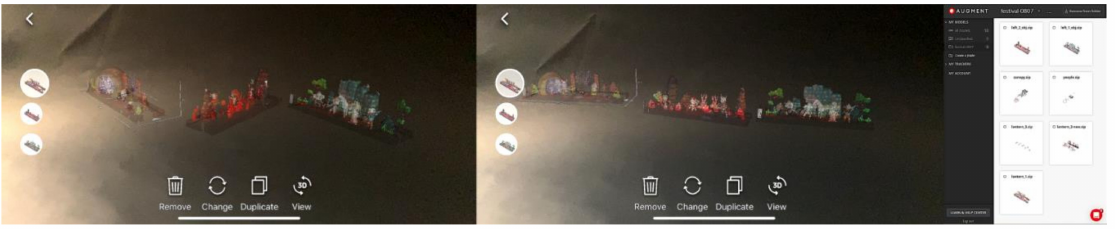
Figure 14. AR app for individual